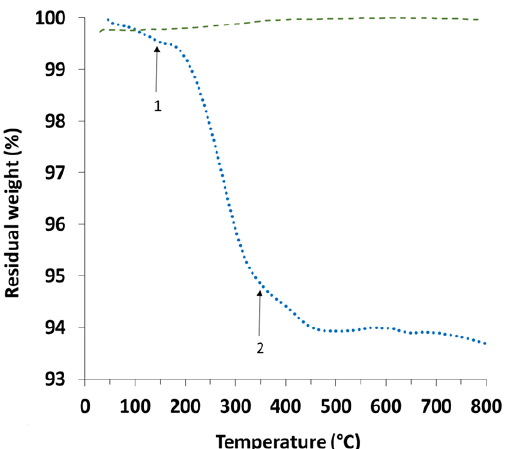
Figure 10. TGA weight loss curve for bare WS 2 nanotubes (dashed green line) and sample INT-PANI-HA (dotted blue line). The two major weight losses are indicated by arrows.